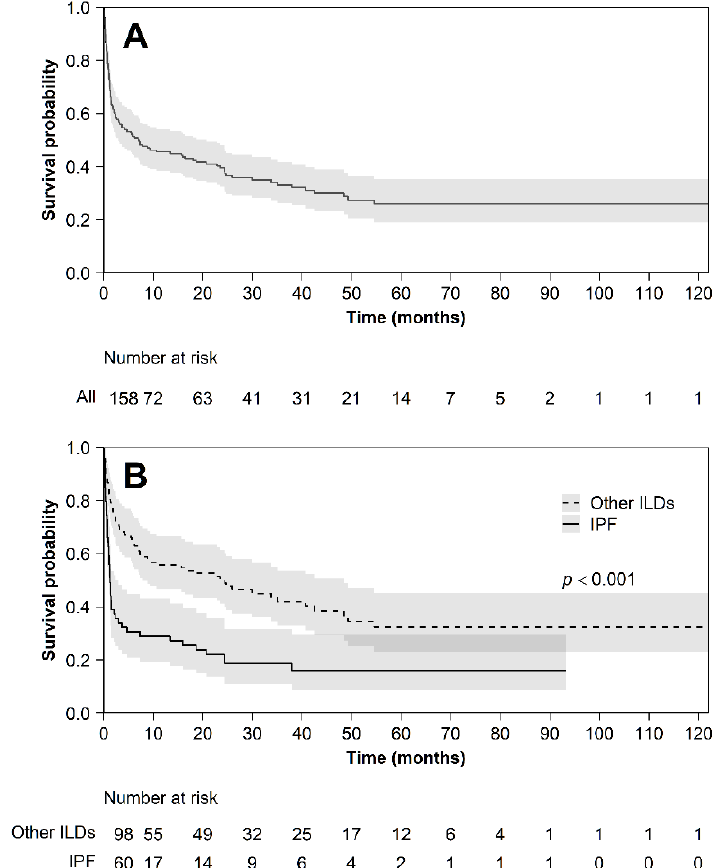
Figure 3. Kaplan–Meier survival curve from the first AE. Panel ( A ) whole cohort; panel ( B ) stratified between subjects with IPF and other ILDs.